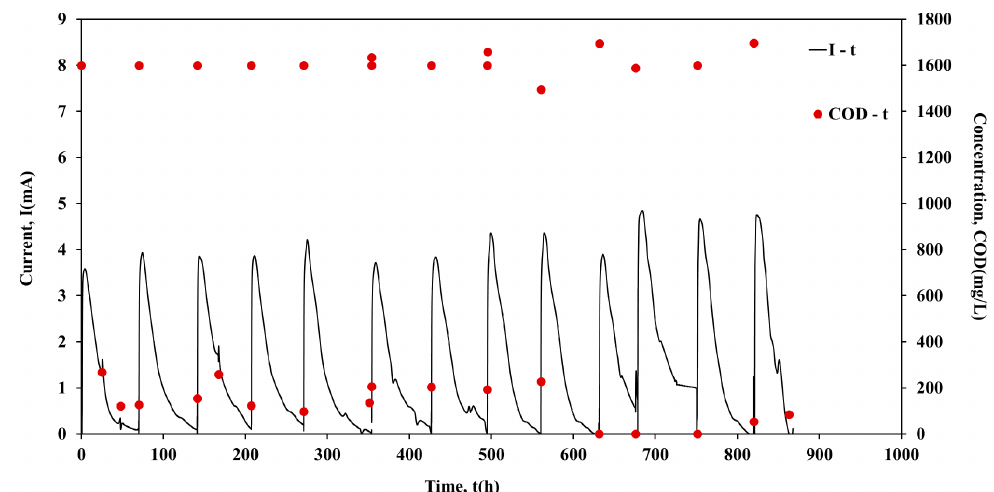
Figure 1. Current output (mA) and COD concentration (mg/L) versus time of Cell 1, during batch operation.